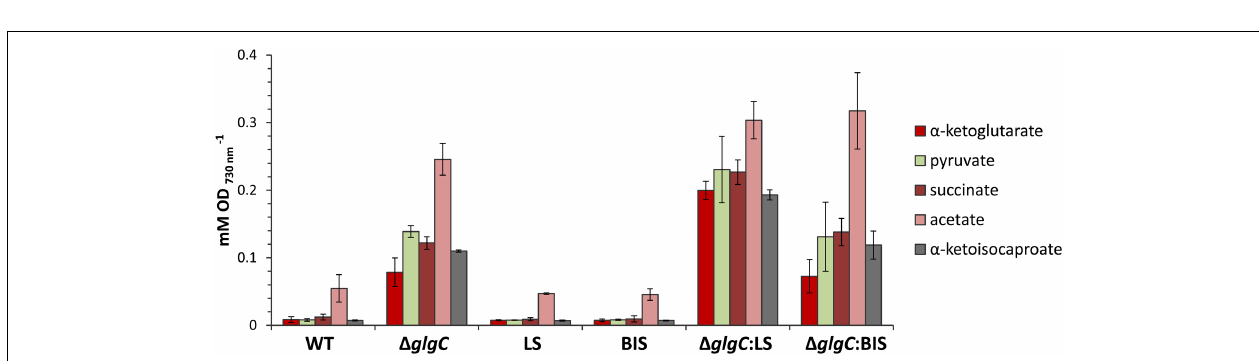
retention times of the metabolites is shown relative to a mixture of 4mM α -ketoglutarate, pyruvate, succinate, acetate, and α -ketoisocaproate standards. (C) Proton NMR spectrum of the secreted metabolites in ∆ glgC , showing chemical shifts and peak splitting patterns that correspond to α -ketoglutarate, pyruvate, succinate, acetate, and α -ketoisocaproate.